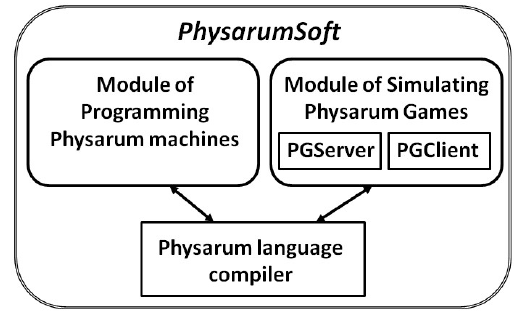
Figure 6: A general structure of PhysarumSoft distinguish three main parts of PhysarumSoft